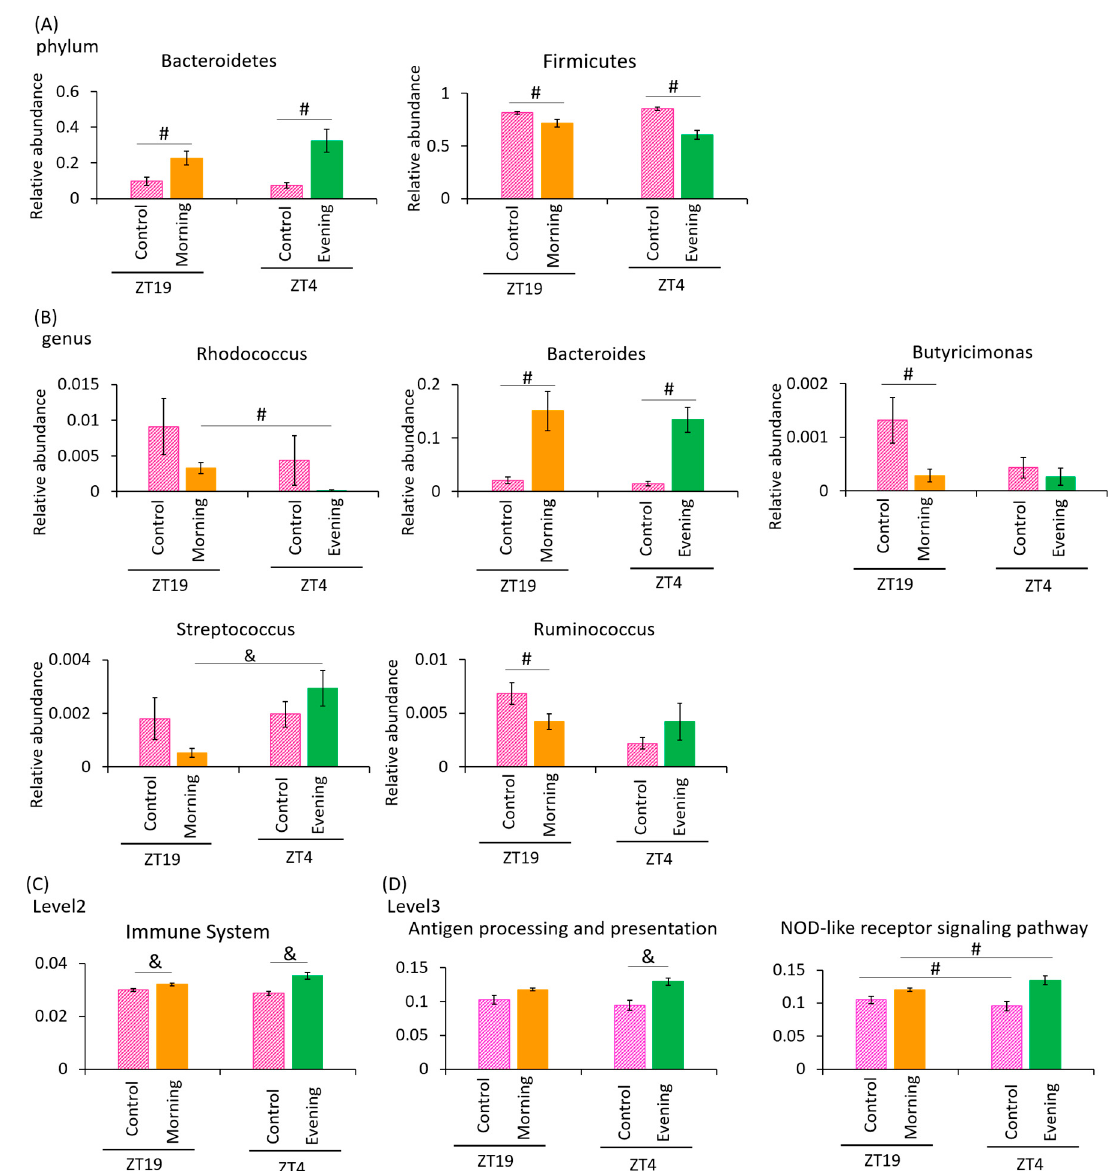
Figure 5. Effect of A. lappa intake in the morning or evening on the relative abundance of some bacteria and prediction of function by PICRUSt analysis. ( A ) The relative abundance of phylum level, ( B ) genus level in each group, ( C ) PICRUSt analysis of immune system, and ( D ) antigen processing and presentation and the NOD-like receptor signaling pathway. All data are represented as mean ± SEM ( n = 5 for each group). # p < 0.05 evaluated using the Mann–Whitney U test with Dunn’s post hoc analysis and two-stage linear step-up procedure of the Benjamini, Krieger, and Yekutieli test for multiple comparisons. & p < 0.05 evaluated using two-way ANOVA with Tukey’s post hoc test. The morning group took A. lappa during ZT12–ZT15 and was sacrificed at ZT19. The evening group took A. lappa during ZT21–ZT24 and was sacrificed at ZT4.